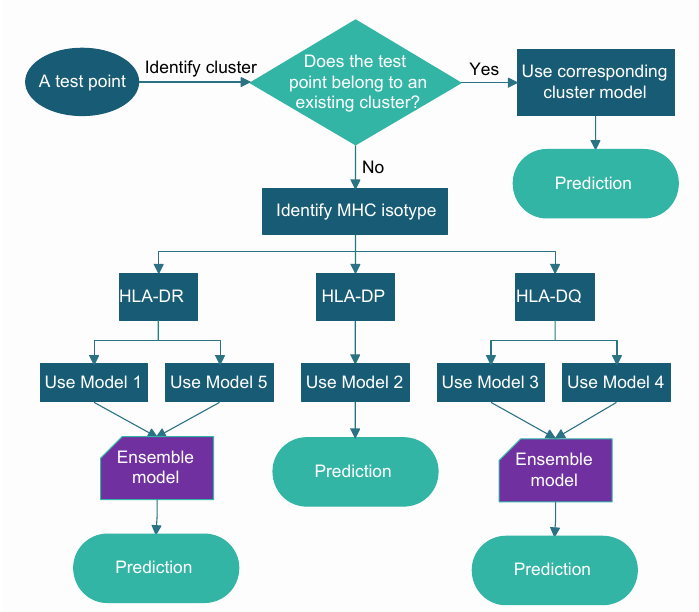
Figure 5. Schematic illustration of making a prediction on a test